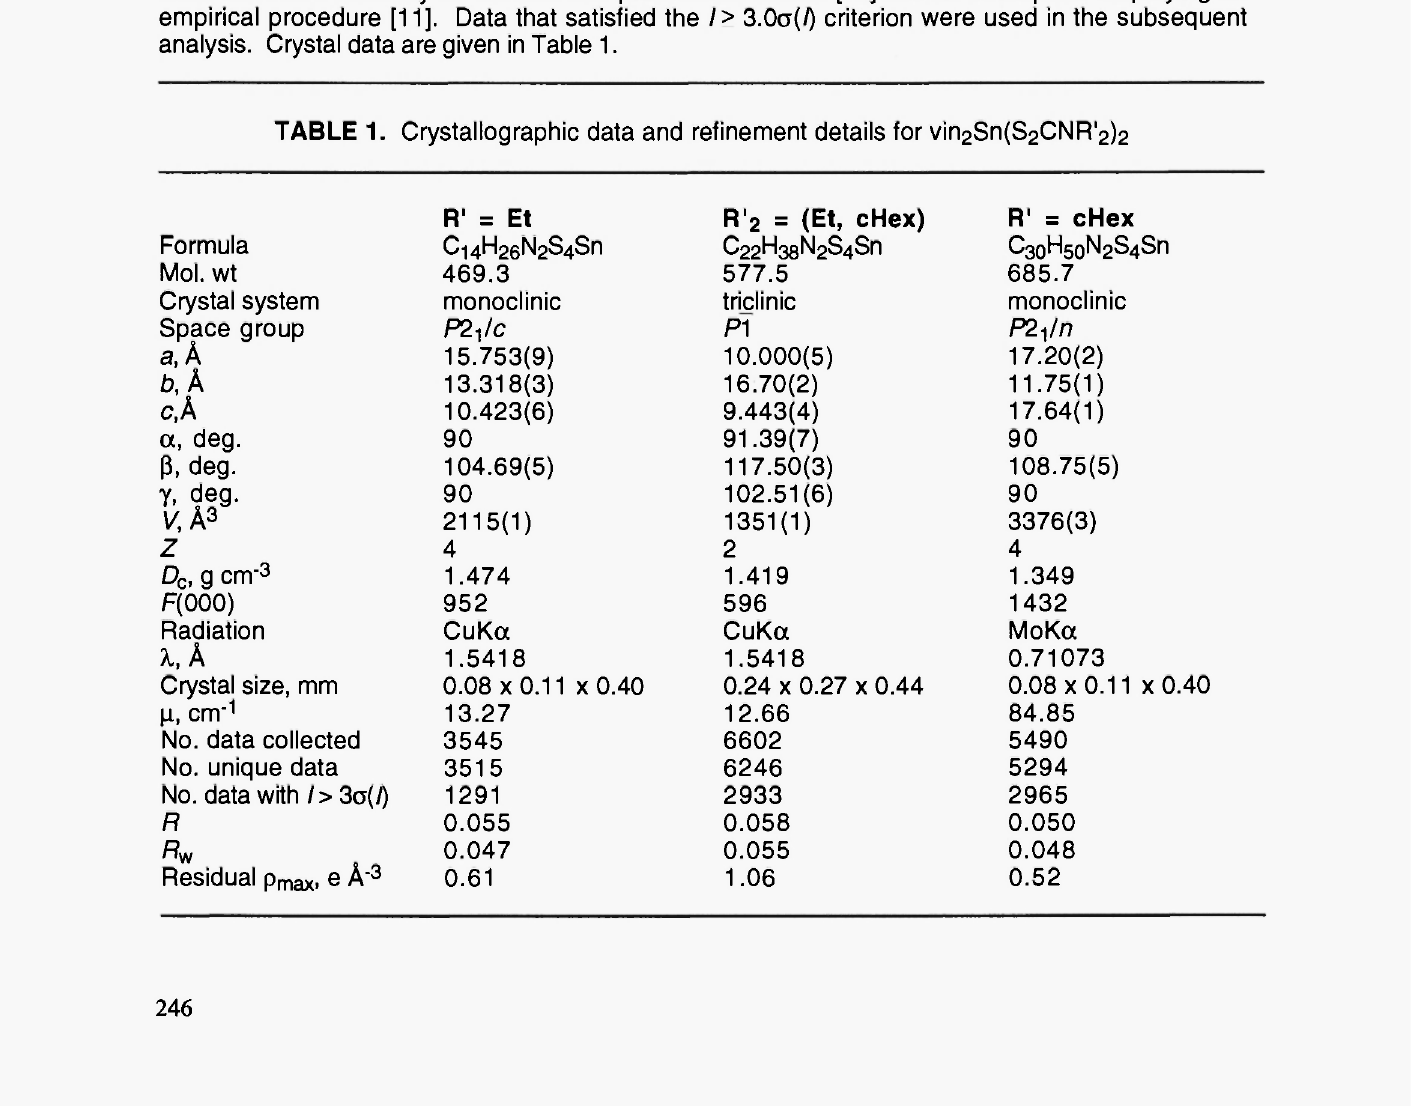
TABLE 1. Crystallographic data and refinement details for vin 2 Sn(S 2 CNR' 2 )